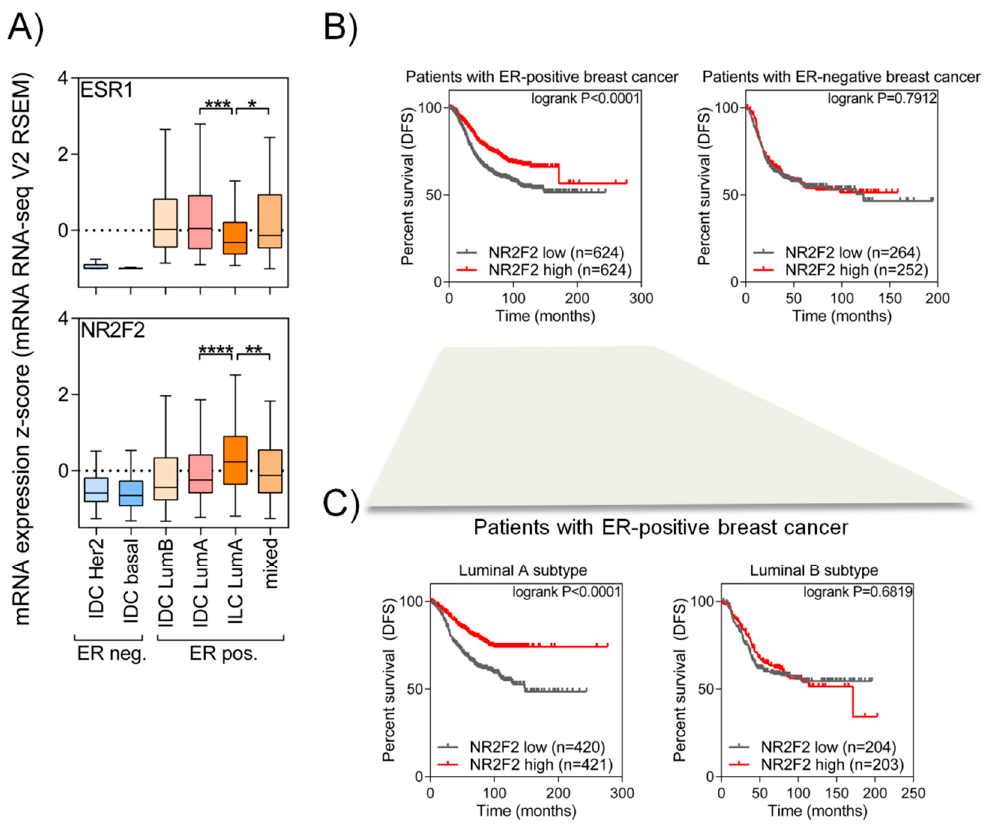
Figure 1. NR2F2 shows a high expression level in patients with ER α positive breast cancer. ( A ) Box plots show differences in ESR1 (encoding ER α ) (upper panel) and NR2F2 (lower panel) gene expression between each subtype of breast cancer patients. Mann-Whitney test, * significant at p < 0.05, ** p <0.01, *** p <0.001, **** p <0.0001 values. ( B ) Kaplan-Meier analysis shows the disease-free survival of patients with ER α positive and ER α negative breast cancer based on high or low NR2F2 expression. Mantel-Cox test was used. ( C ) Kaplan-Meier analysis shows the disease-free survival of patients with luminal A and luminal B breast cancer based on high or low NR2F2 expression. A Mantel-Cox test was used.